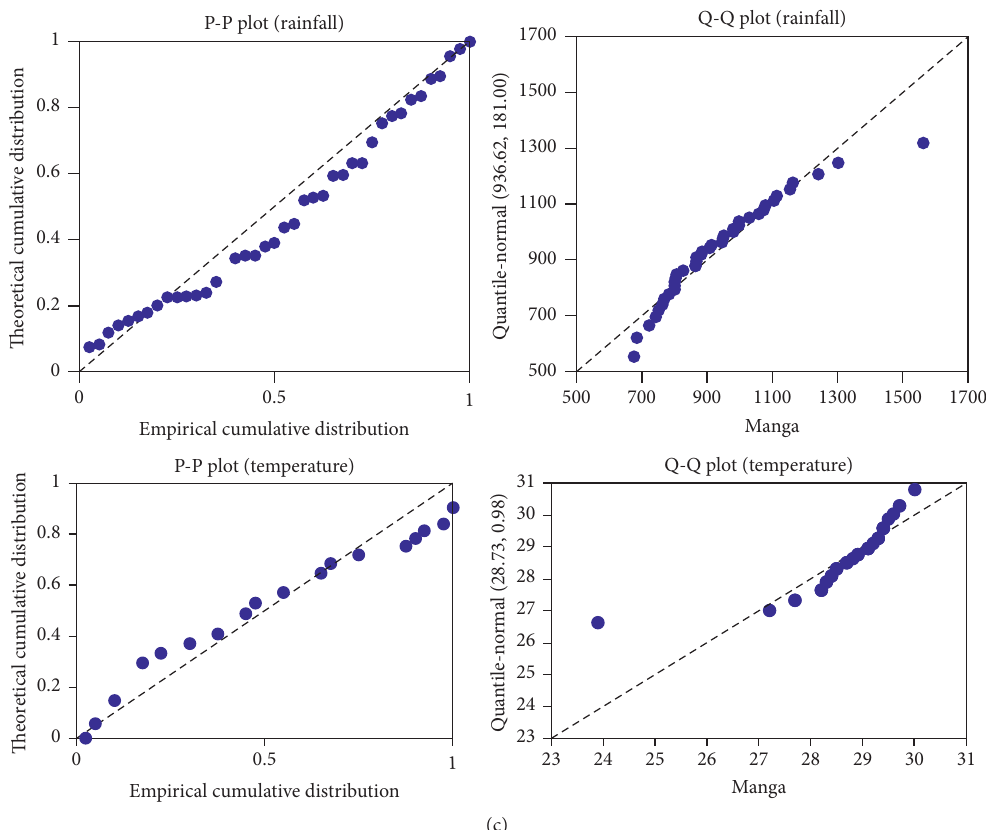
Figure 2: Visual inspection of P-P and Q-Q plots for rainfall and temperature. (a) Binduri gauge station. (b) Garu-Tempane gauge station. (c) Manga gauge